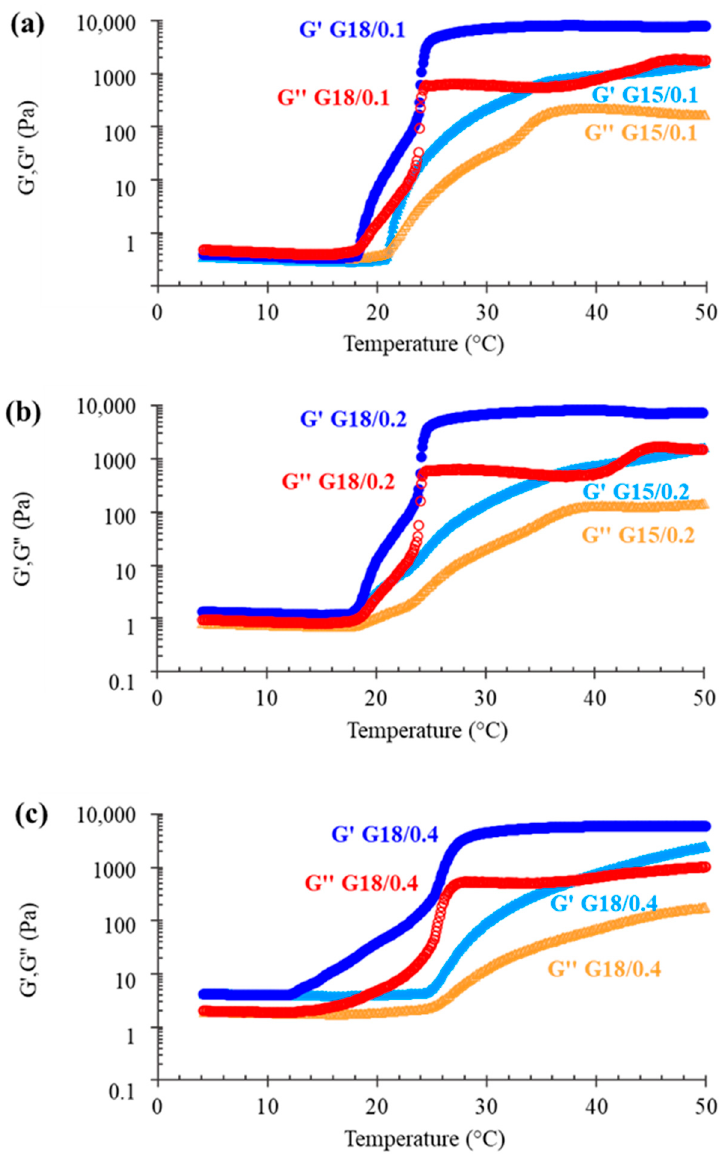
Figure 2. Variation of elastic G ′ and viscous G ″ moduli as a function of temperature; analyses were performed on gels based on p-407 15 or 18% and x-gum 0.1 ( a ), 0.2 ( b ), or 0.4 ( c ) %, w / w .